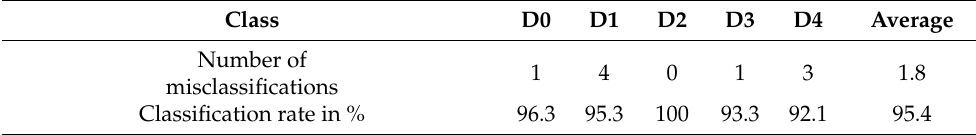
Table 2. Classification results for the training samples of Table 1.